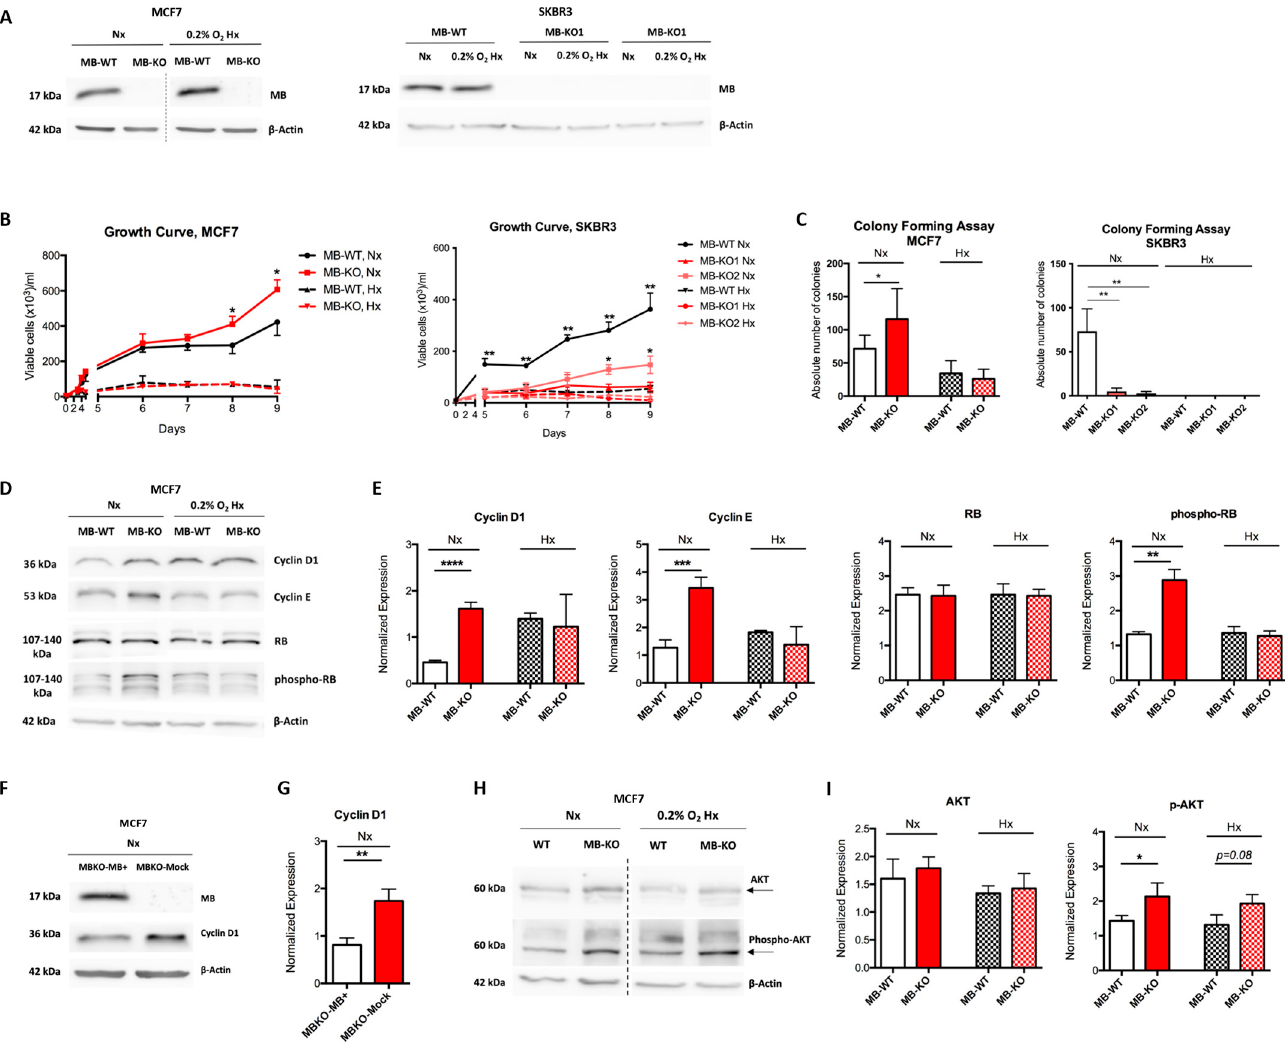
Figure 1. Myoglobin impacts breast cancer cell survival. ( A ) Representative Western blot stained for myoglobin (MB) (17 kDa) to verify the MB knockout (MB-KO) in MCF7 and SKBR3 cells. Cells were exposed to normoxia (Nx) or hypoxia (Hx, 0.2% O 2 ) for 72 h prior to protein extraction ( n = 4). ( B ) Growth curves of MB-KO vs. MB-WT of MCF7 ( left panel ) and SKBR3 ( right panel ) at Nx and 0.2% O 2 Hx, respectively. Cells were stained with trypan blue, and dead cells defined by their blue appearance were excluded from counting ( n = 3). ( C ) Colony assay performed using MB-WT and MB-KO clones of MCF7 ( left panel ) and SKBR3 ( right panel ). Cells were seeded at low confluency and incubated in Nx or 0.2% O 2 Hx for 9 days. Colonies (>50 cells) stained with crystal violet were counted using a binocular ( n = 5). ( D ) Representative Western blotting image of whole tissue lysate of MB-WT and MB-KO clones of MCF7 cells cultured at Nx or 0.2%O 2 Hx for 72 h and stained for cyclin-D1 (33 kDa), cyclin E (53 kDa), retinoblastoma (RB) (130 kDa), phospho-retinoblastoma (p- RB) (130 kDa), and β -actin (42 kDa) used as the loading control ( n = 4). ( E ) Band intensity of cyclin D1, cyclin E, RB, and phospho-RB proteins after Western blotting, from MB-WT (white) and MB- KO (red) MCF7 cells at Nx (empty bars) and 0.2%O 2 Hx (dashed bars), was quantified using MCID